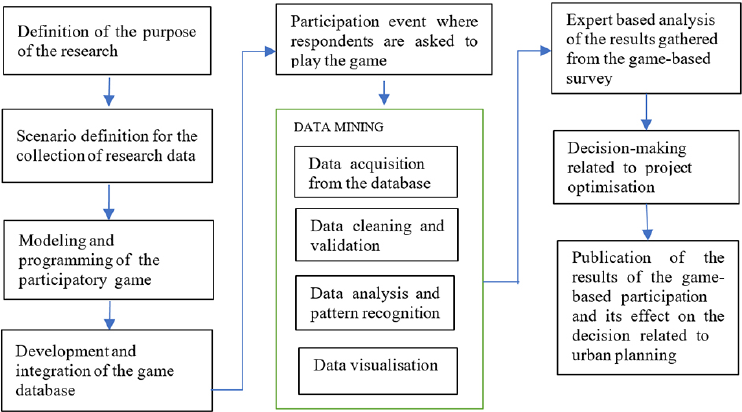
Figure 1. GBS involvement in the modern public space planning